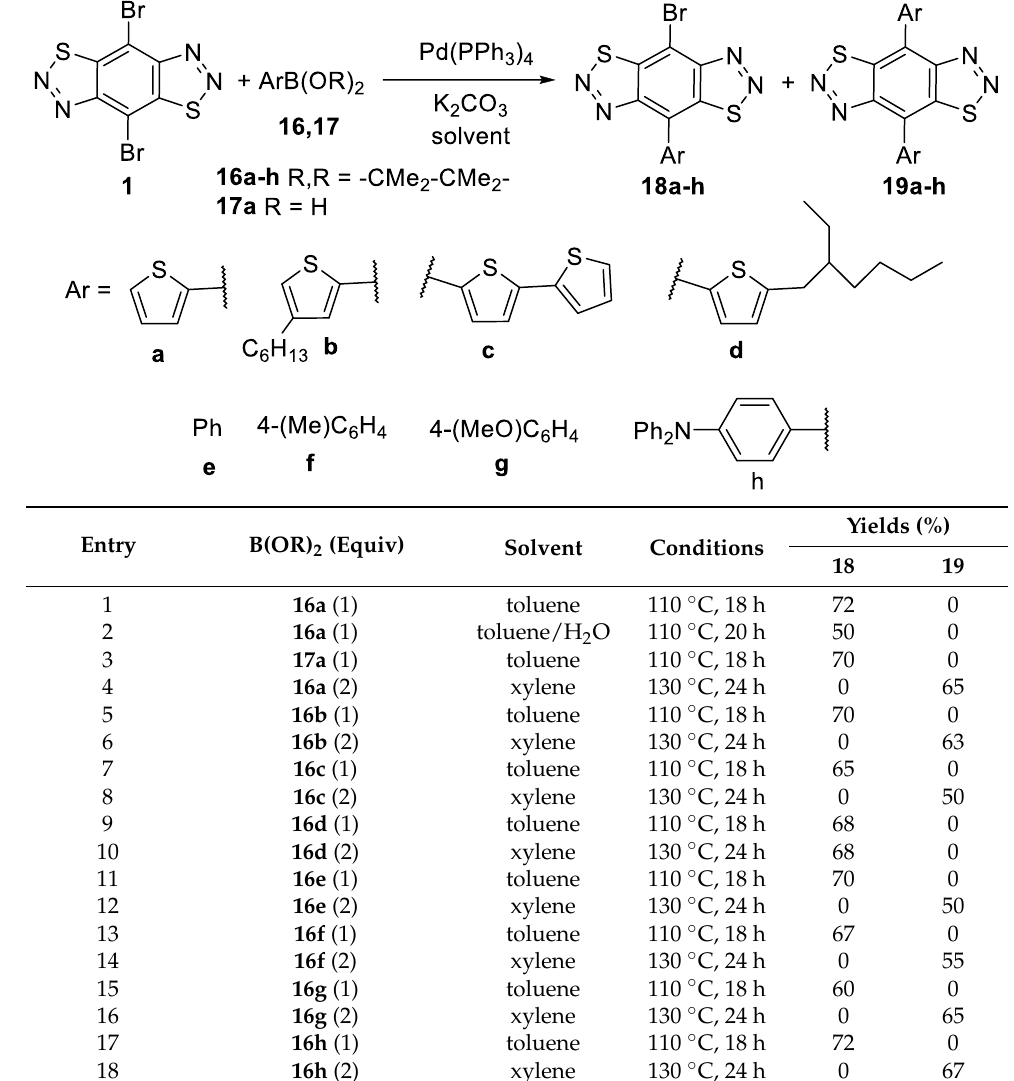
Table 6. Stille cross-coupling of 4,8-dibromobenzo[1,2- d :4,5- d ’ ]bis([1,2,3]thiadiazole) 1 with aryl- and heteroaryl-tributylstannanes 20a